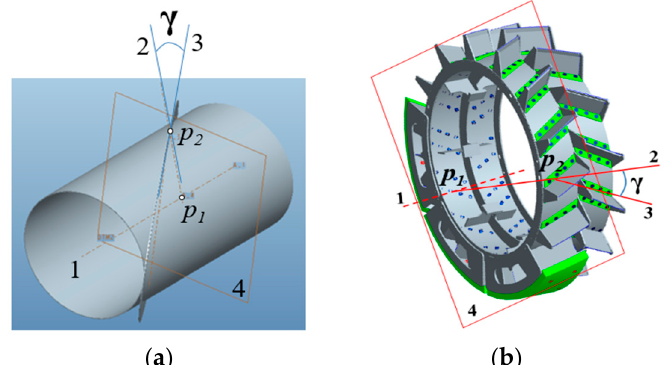
6 of 21 plane 4; angle gamma ( γ ): mounting angle of iron wheel lug faceplate; that is the angle between line 2 and line 3 at vertex point p2. In Figure 3, the obliquely upward direction vector of line 2 obtained from Equation (4) is as follows: 𝑛(cid:4652)⃗ (cid:2870) = 𝑅 sin 𝜃. 𝚥⃗ + 𝑅 cos 𝜃. 𝑘(cid:4652)⃗ (5) In the coordinate system xyz, line 3 is parallel to the z-axis, so the angle between line